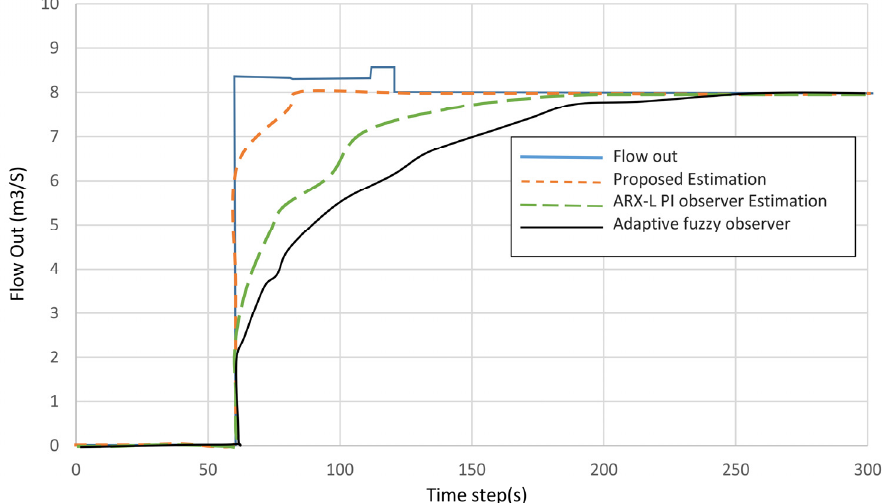
Figure 5. The effectiveness of the proposed technique for fault estimation under no-fault condition.